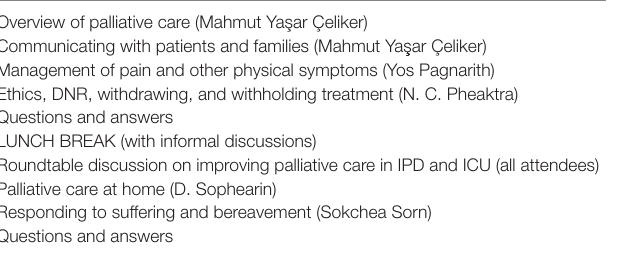
taBLe 3 | Schedule of the first full-day workshop on pediatric palliative care at Angkor Hospital for Children. Overview of palliative care (Mahmut Yas ̧ ar Çeliker) Communicating with patients and families (Mahmut Yas ̧̧̧ ar Çeliker) Management of pain and other physical symptoms (Yos Pagnarith) Ethics, DNR, withdrawing, and withholding treatment (N. C.